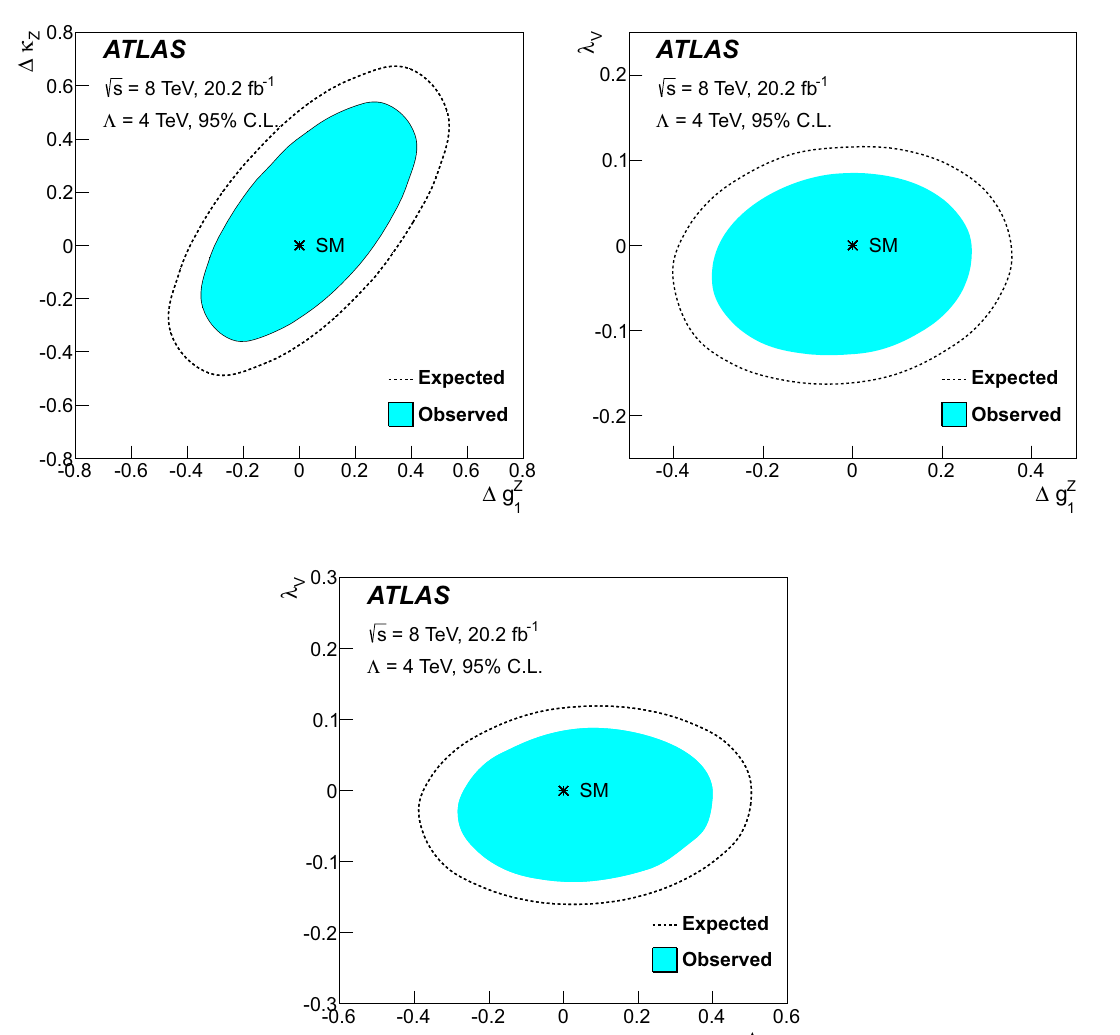
Fig. 29 The observed ( solid blue ) and expected ( open dashed ) 95% C.L. allowed regions in two-parameter planes for (cid:19) = 4 TeV. The regions are derived using a single measured yield and therefore reduce to the corresponding one-parameter interval when the other parameter is set to zero. Constraints on ˜ λ V are similar to those on λ